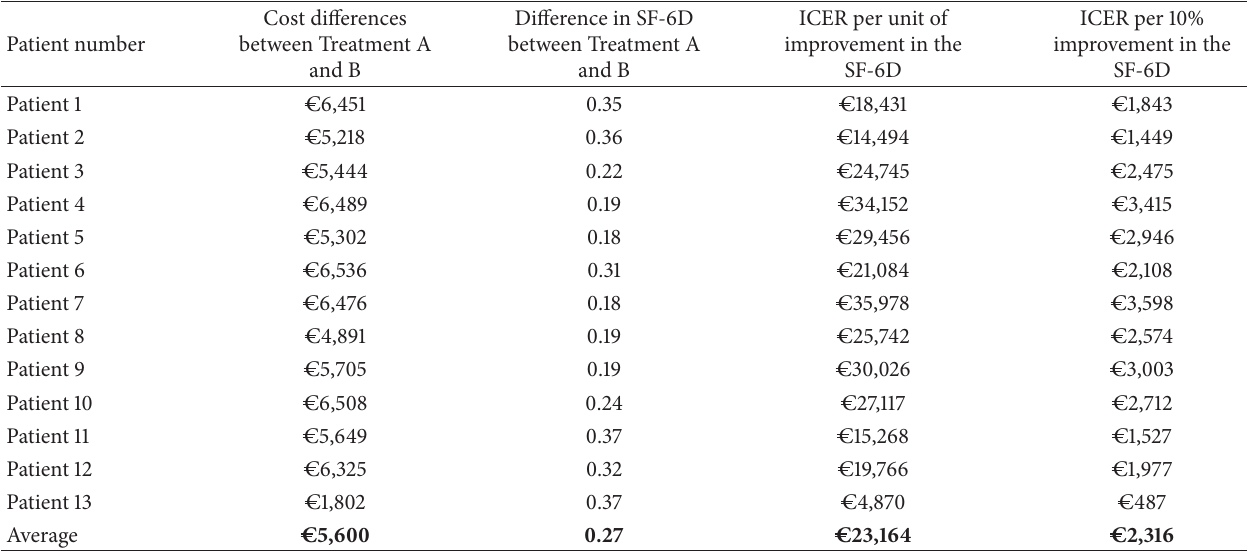
Table 5: Resulting ICERs in terms of improvement in the SF-6D.